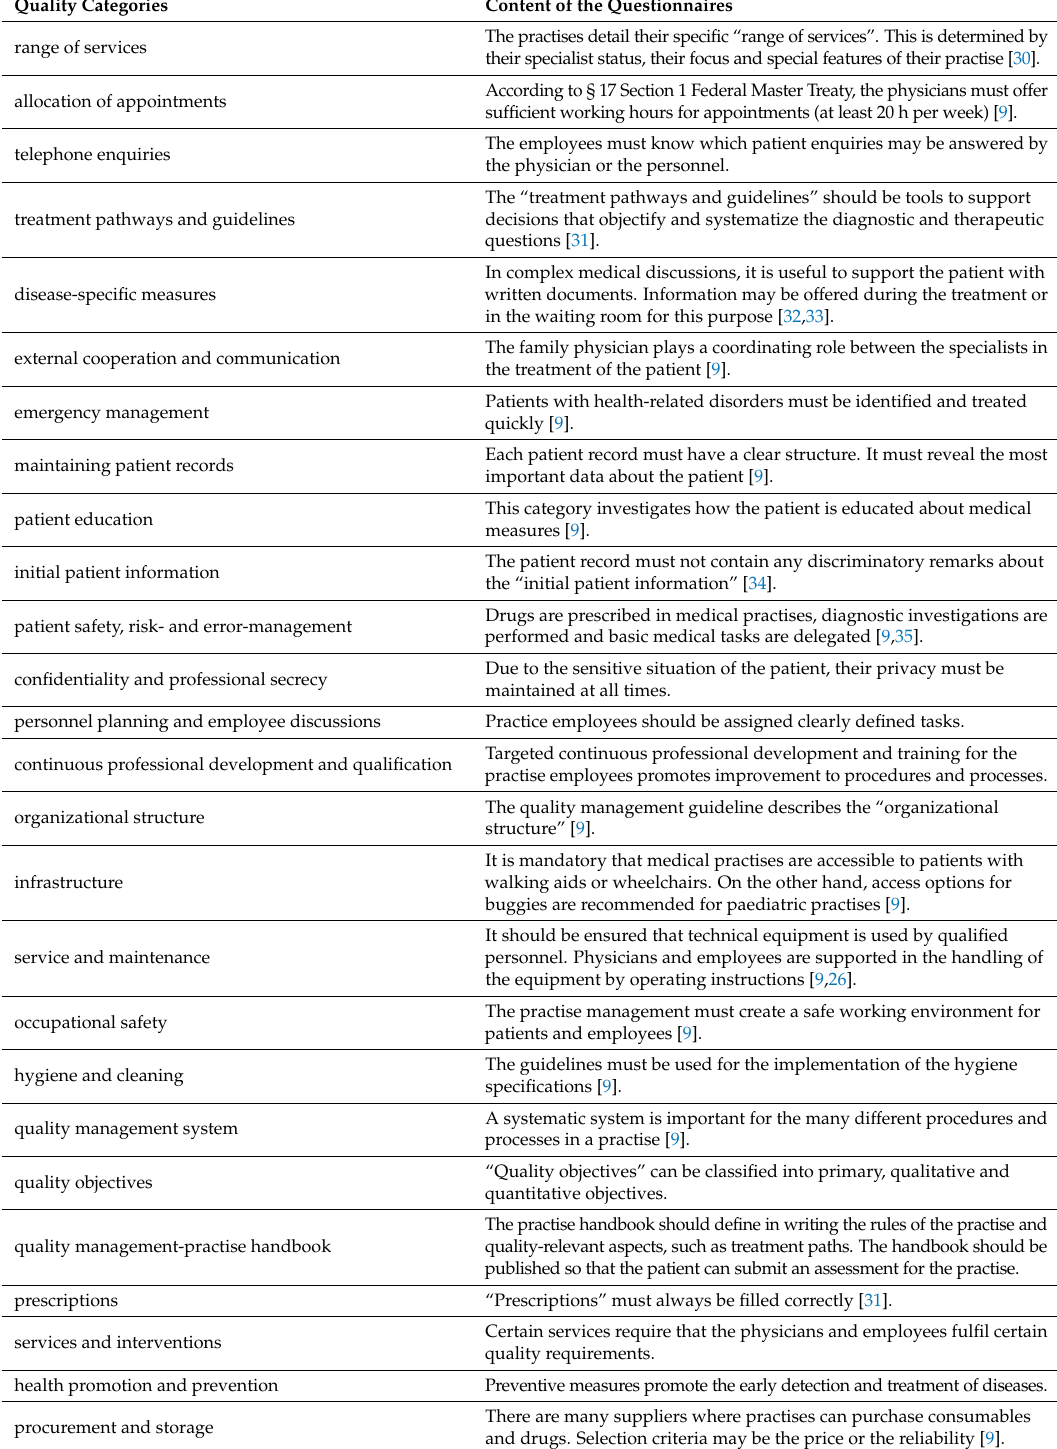
Table 1. Quality